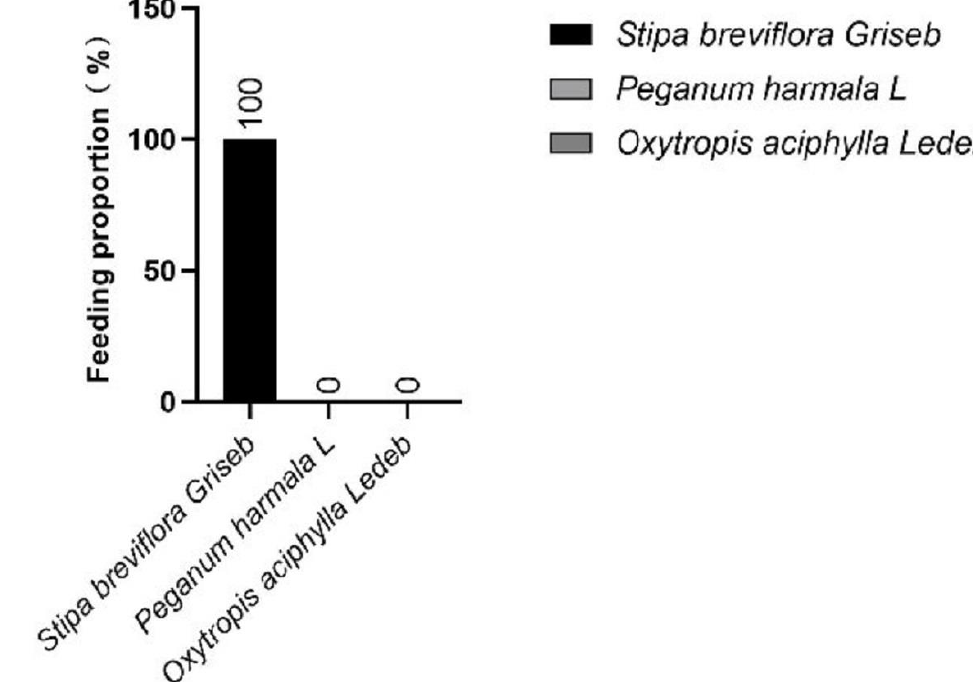
Figure 1. Forage intake proportion of cashmere goats in early gestation (%).